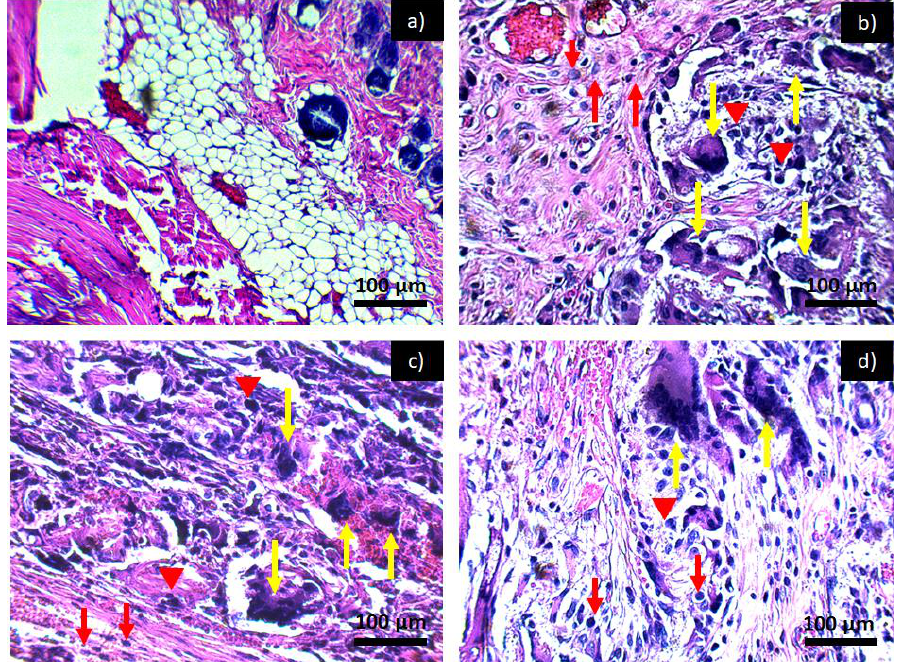
Figure 8. Histological preparation in tissue hematoxylin-eosin with the PCL/ α -Al 2 O 3 : ( a ) control, ( b ) PCL/ α -Al 2 O 3 2 weeks, ( c ) PCL/ α -Al 2 O 3 4 weeks, and ( d ) PCL/ α -Al 2 O 3 6 weeks. Red arrows indicate the presence of lymphocytes, red arrowheads indicate macrophages, and yellow arrows indicate the presence of multinucleated giant cells characteristic of a chronic inflammatory infiltrate.